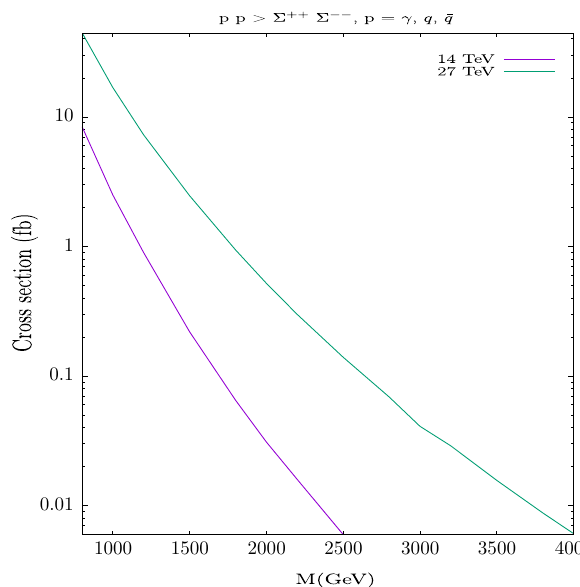
Fig. 4 The cross section for pair production process pp → Z /γ → (cid:4) ++ (cid:4) −− as a function of (cid:4) ±± mass at 14 TeV and 27 TeV −√